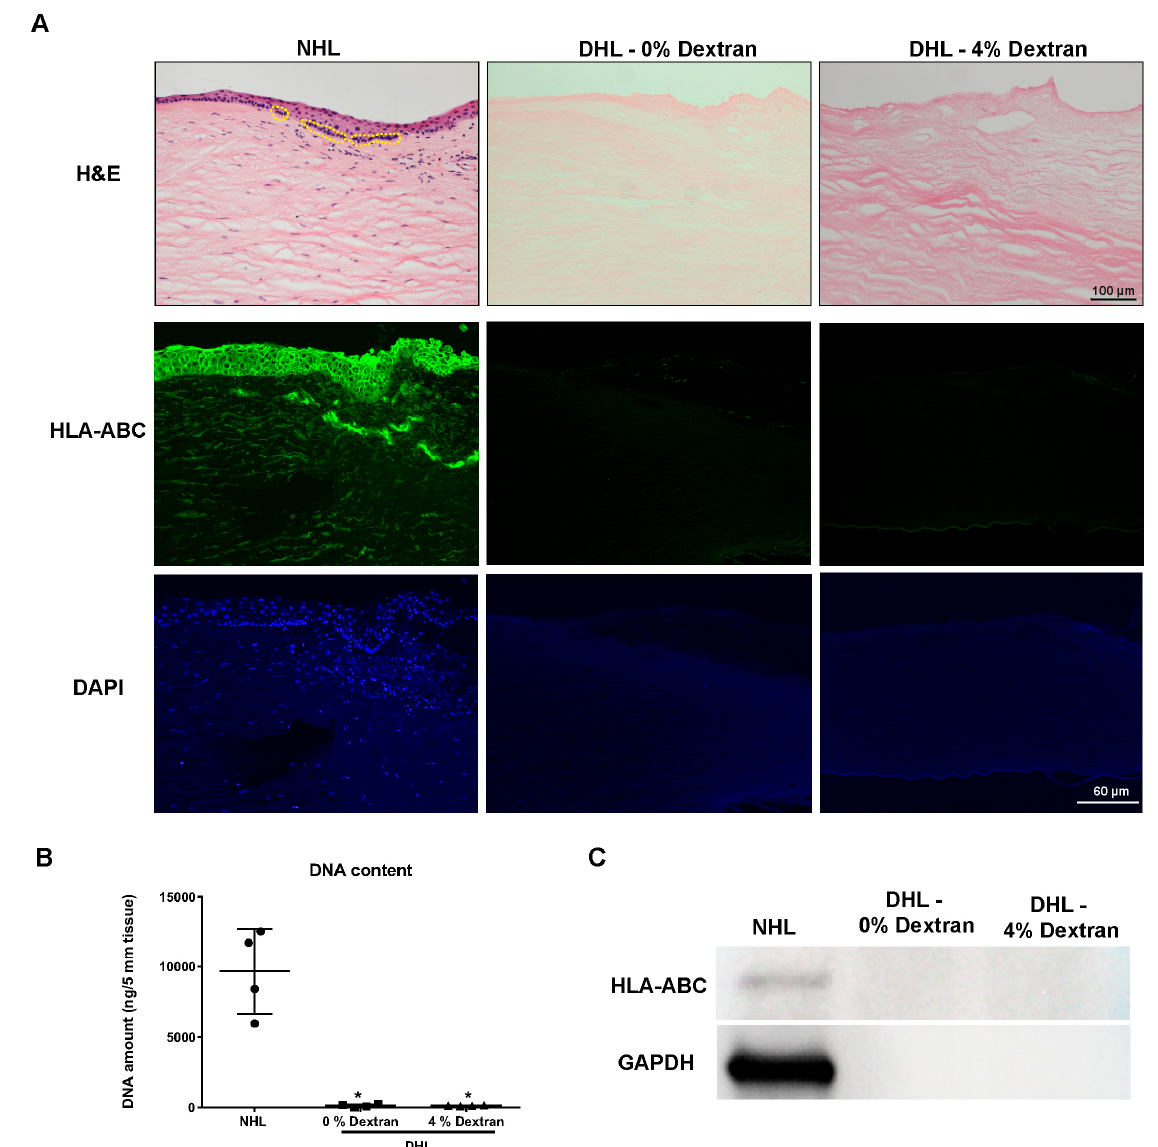
Figure 1. Decellularization efficiency. ( A ) Histological evaluation of human corneal limbus decellularized by sodium deoxycholate (SD) with deoxyribonuclease I in 0 or 4% dextran, in comparison to the normal human limbus (NHL) using hematoxylin and eosin (H&E) staining. The NHL sections show a multilayered epithelium with darkly stained cell clusters (yellow dotted circle) and stromal cells, whereas decellularized human limbus (DHL) sections show no cell remnants. HLA-ABC staining (green) of NHL and DHL showing cellular expression of HLA in NHC; No HLA expression in DHL scaffolds. DAPI staining reveals nuclei in NHL without remaining nuclei/nuclear debris in DHL. ( B ) Confirmation of decellularization by quantification of residual DNA. The graph represents the quantity of DNA in both NHL and DHL (0 or 4% dextran). Data are expressed as means ± S.E.M. ( n = 4). * p < 0.05; Mann–Whitney U test. ( C ) Western blot showing the band of GAPDH and HLA-ABC in the NHL; No bands in the DHL in 0 or 4% dextran. Uncropped version of Western blot is shown in Supplementary Figure S1. Abbreviations: DAPI, 4 (cid:48) ,6-diamidino-2-phenylindole; HLA, human leukocyte antigen; GAPDH, Glyceraldehyde-3-phosphate dehydrogenase.